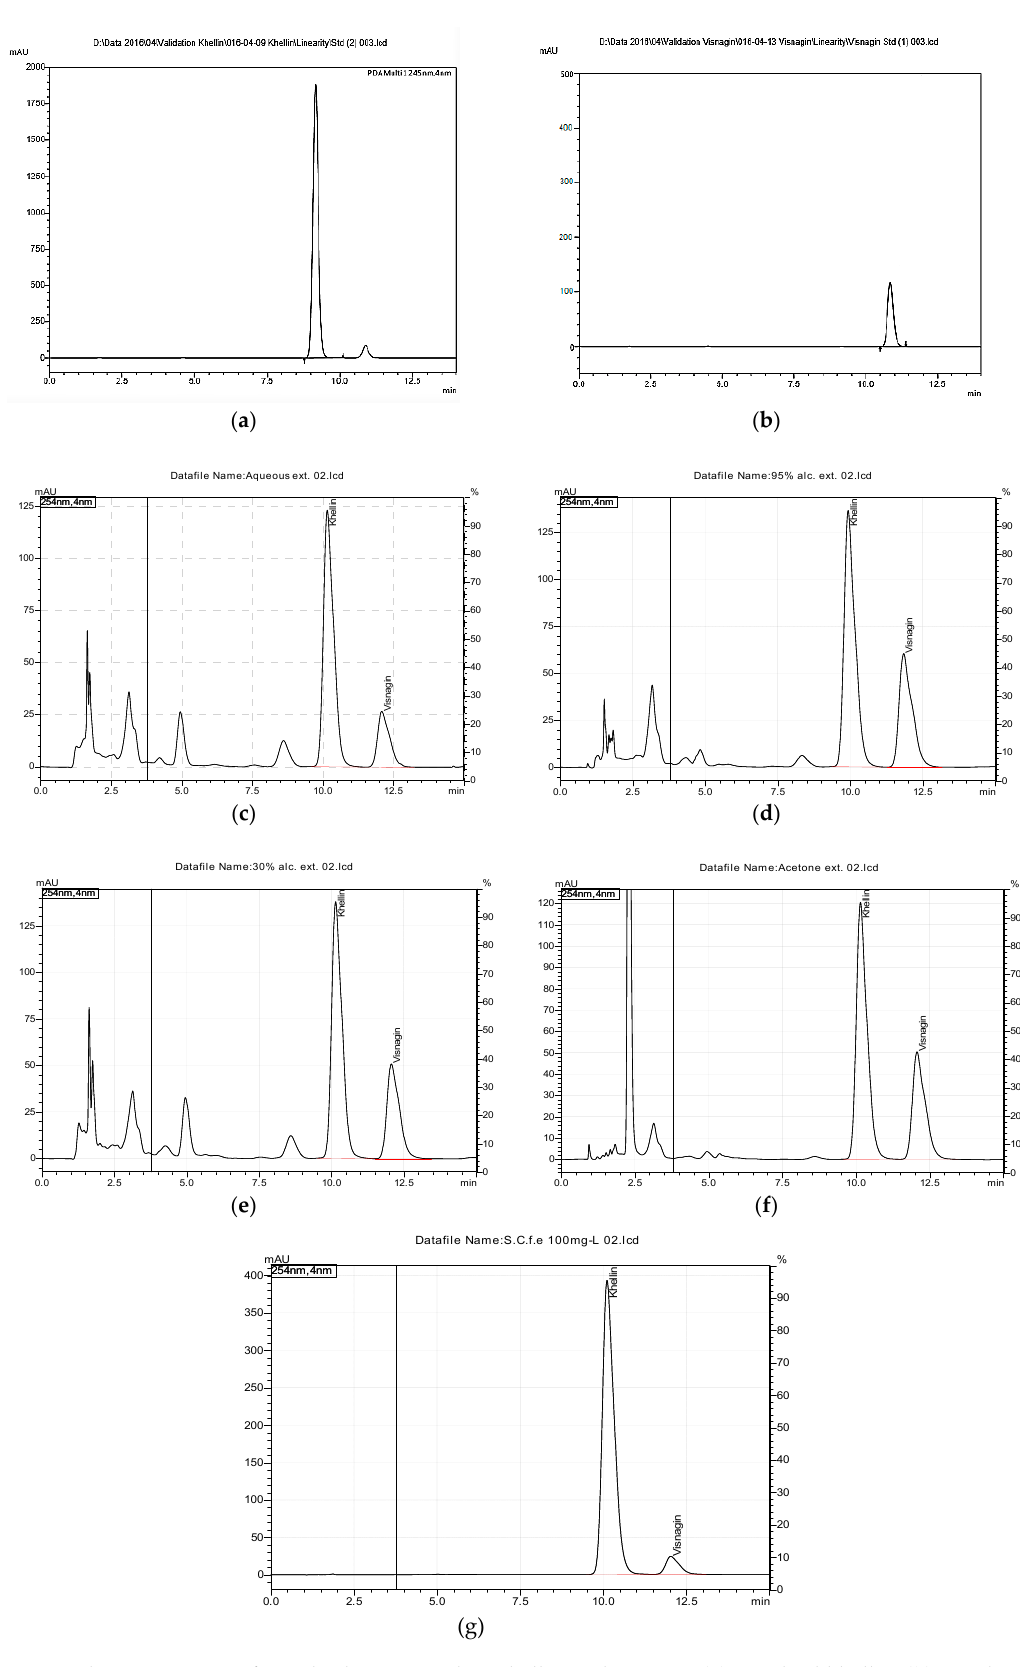
Figure 1. HPLC chromatograms of standard compounds and all tested extracts. ( a ) standard khellin, ( b ) standard visnagin, ( c ) aqueous extract, ( d ) 95% ethanolic extract, ( e ) 30% ethanolic extract, ( f ) acetone extract, ( g ) supercritical fluid extract.